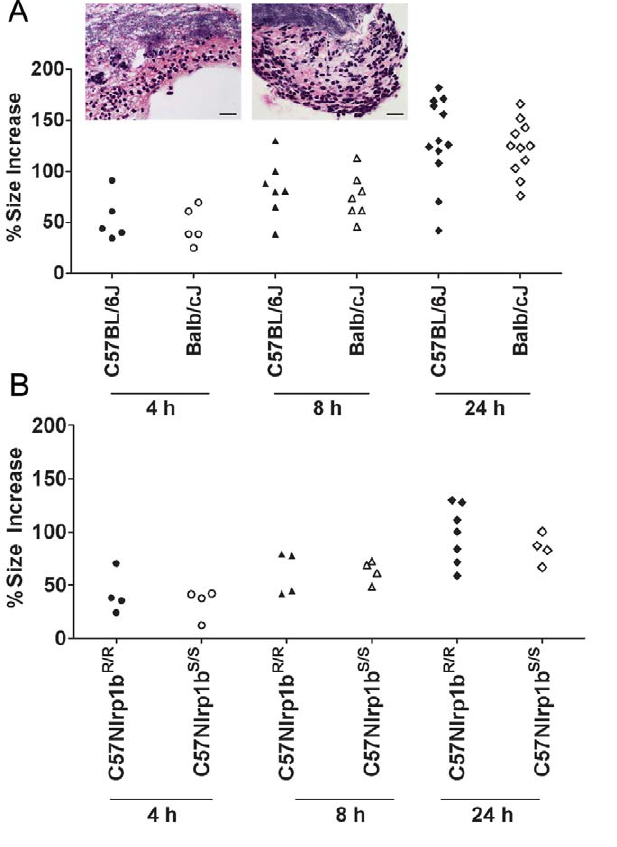
Figure 3. Nlrp1 does not control spore germination. Percent increases in foot edema dorsal/ventral measurements relative to PBS- treated controls are shown at 4, 8, and 24 h following spore injection (2 6 10 7 , 50 m l, SC). P-values comparing Balb/cJ and C57BL/6J at all time points were . 0.388 (panel A). P-values comparing C57BL/6NTac Nlrp1b S/S and C57BL/6NTac Nlrp1b R/R at all three time points were . 0.5 (panel B). Inset panels show H&E (or B&H) staining of skin sections in C57BL/6J (left) or Balb/cJ (right) mice 8 h after SC spore infection (2 6 10 7 ). Germinated bacteria can be seen in the upper half of each panel with neutrophil influx in the lower half. Neutrophil influx was also verified by myeloperoxidase immunostaining (not shown). Image is taken at 400 6 magnification (scale bar =25